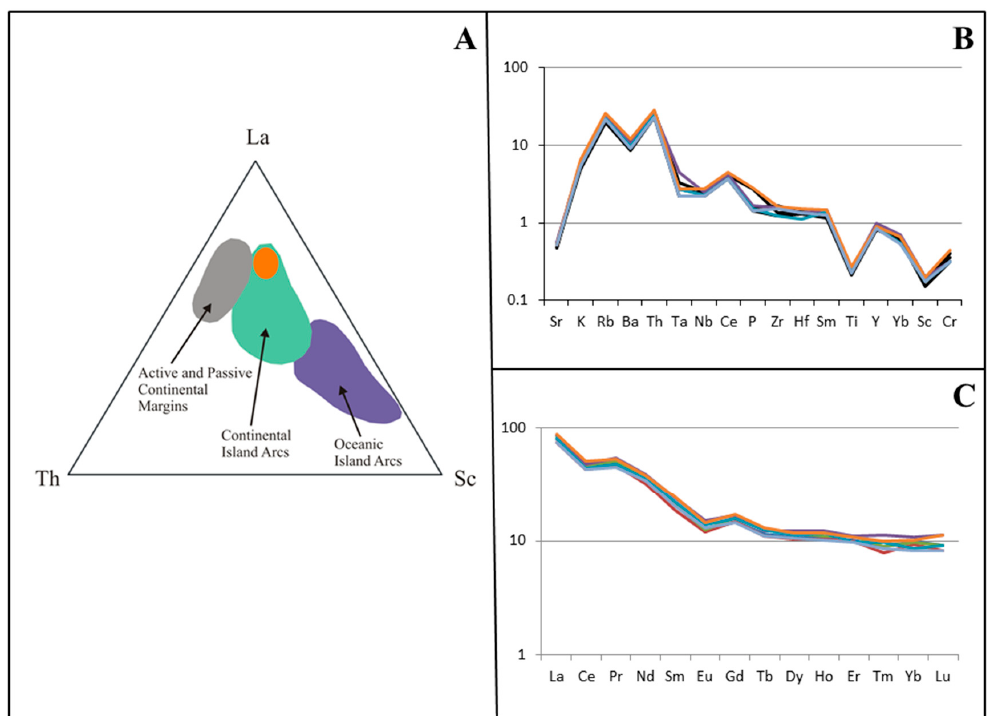
Figure 7. ( A ) Trace element La-Sc-Th ternary plot for Selinitsa Cave fine-grained deposits (orange elipse) (based on [39]). ( B , C ) Multi-element spider plots for Selinitsa Cave fine-grained deposits. ( B ) MORB-normalized diagram (normalized values based on [40]). ( C ) REE-normalized diagram (normalized values based on